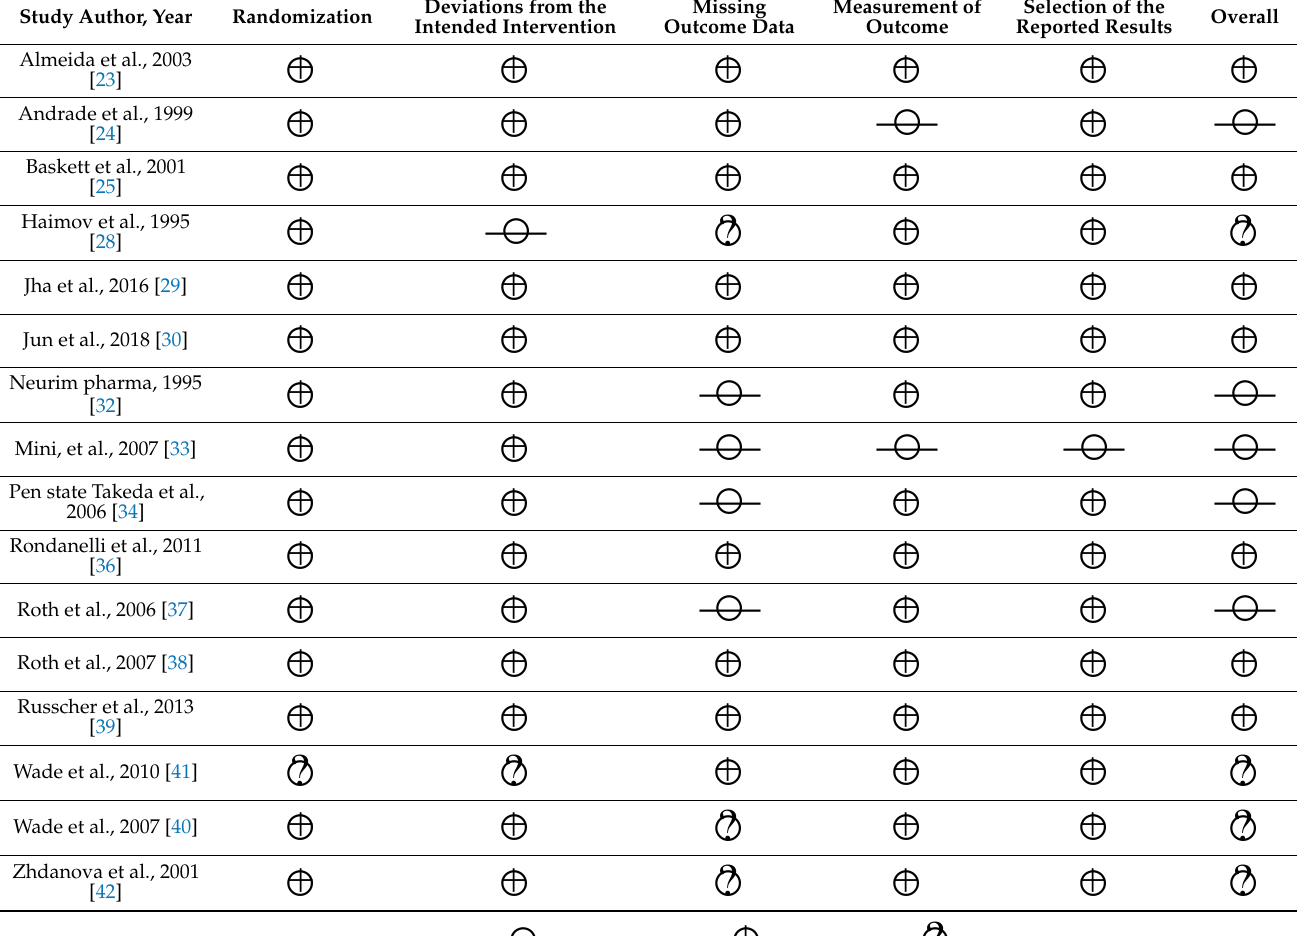
Table 3. Risk of bias.